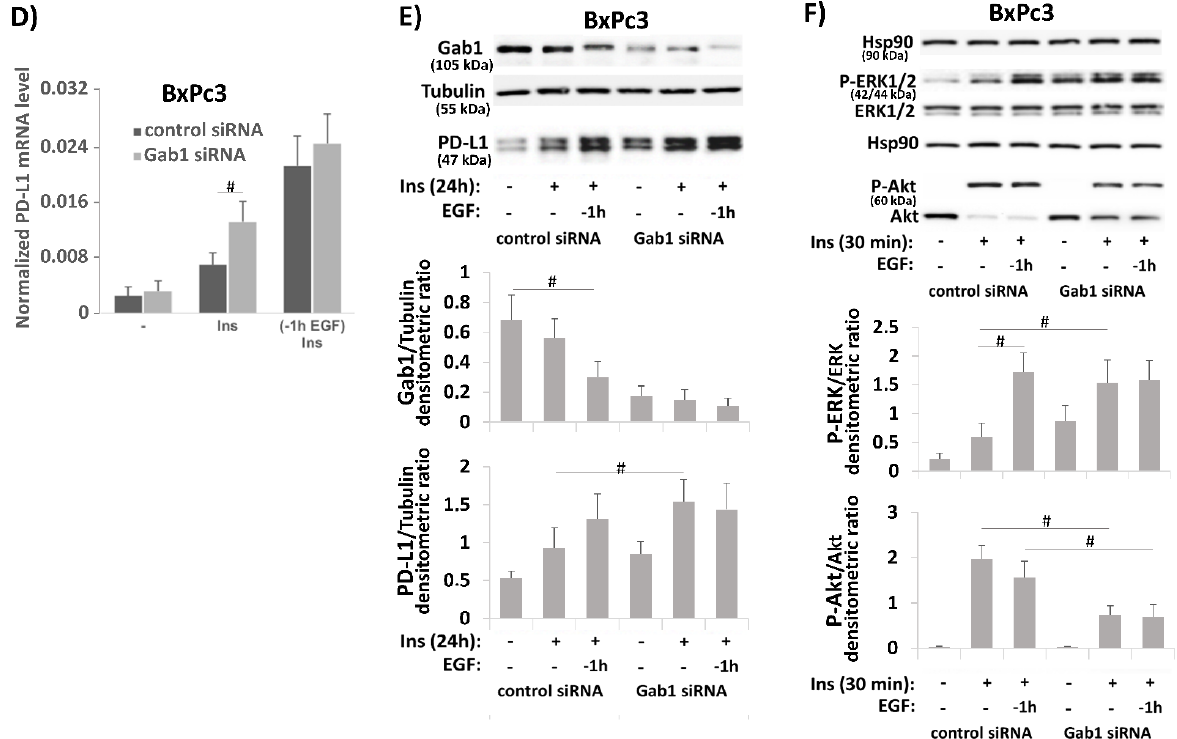
Figure 5. The effect of EGF on insulin-induced PD-L1 expression in PDAC cells involves different mechanisms. ( A , B ) Serum-starved A818-6, T3M4, and BxPc3 cells were either left untreated or treated with 10 ng/mL EGF for ( A ) 24 h or ( B ) 6 h and 24 h. ( A ) Western blot analysis using InsR and tubulin antibodies. ( B ) qPCR analysis using InsR-A, InsR-B, and RPL13 primers. InsR-A and InsR-B expression is normalized to the expression level of RPL13, and data represent the mean ± SD from four independent experiments (* p < 0.02 compared to untreated). ( C ) Serum-starved A818-6, T3M4, and BxPc3 cells were either left untreated or treated with 0.1 IU/mL insulin for 30 min either alone or after preincubation for the indicated periods with 10 ng/mL EGF. Then, Western blot analysis using Gab1 and tubulin antibodies was performed. ( D – F ) BxPc3 cells were treated with control or Gab1 siRNA for 24 h followed by serum starvation for 24 h. Then, cells either left untreated or were treatment with 0.1 IU/mL insulin for 16 h ( D ), 24 h ( E ) or 30 min ( F ) either in the absence or presence of 10 ng/mL EGF administered 1 h before. ( D ) qPCR analysis using PD-L1 and RPL13 primers. PD-L1 expression is normalized to the expression level of RPL13, and data represent the mean ± SD from four independent experiments (* p < 0.05). ( E , F ) Western blot analysis using ( E ) PD-L1, Gab1, and tubulin antibodies or ( F ) P-ERK1/2, ERK1/2, P-Akt, Akt, and Hsp90 antibodies. ( A , C , E , F ) Representative blots from four independent experiments and band densitometry analyses (lower panels, # p < 0.05, n = 4) are shown.